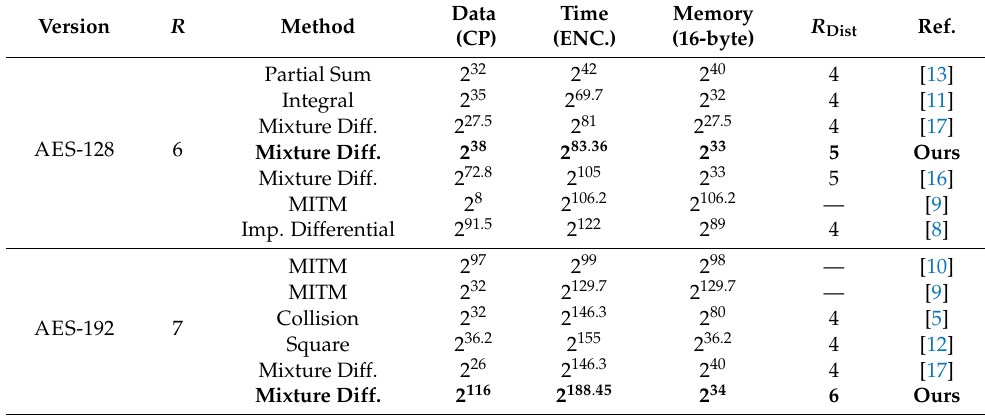
Table 4. Comparison of attacks on 6- and 7-round AES. ( R Dist is the number of rounds of the distinguisher exploited to set up the attack. Our results are highlighted in bold). Data Version R Method